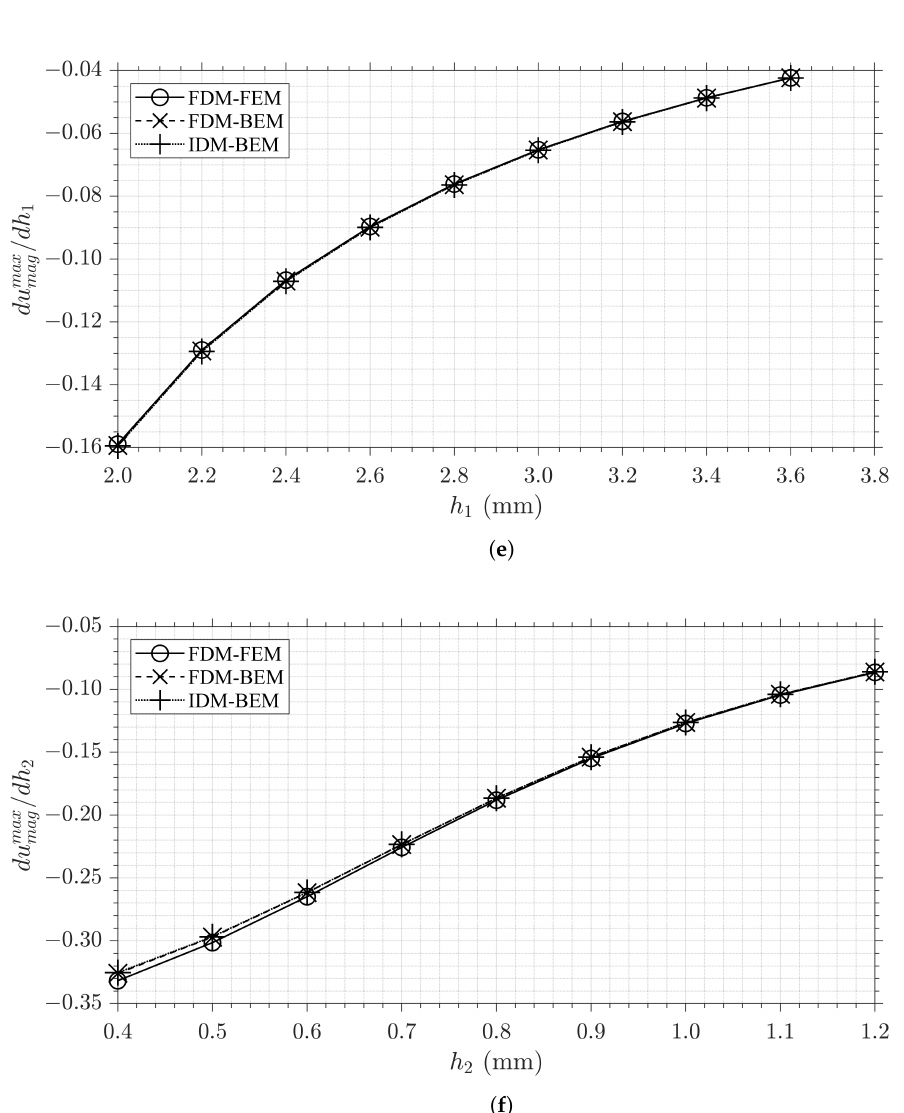
Figure 19. The sensitivities of the maximum displacement magnitude u max mag with respect to ( a ) W 1 , ( b ) W 2 , ( c ) L 1 , ( d ) L 2 , ( e ) h 1 , and ( f ) h 2 for the three methods ‘IDM-BEM’, ‘FDM-BEM’, and